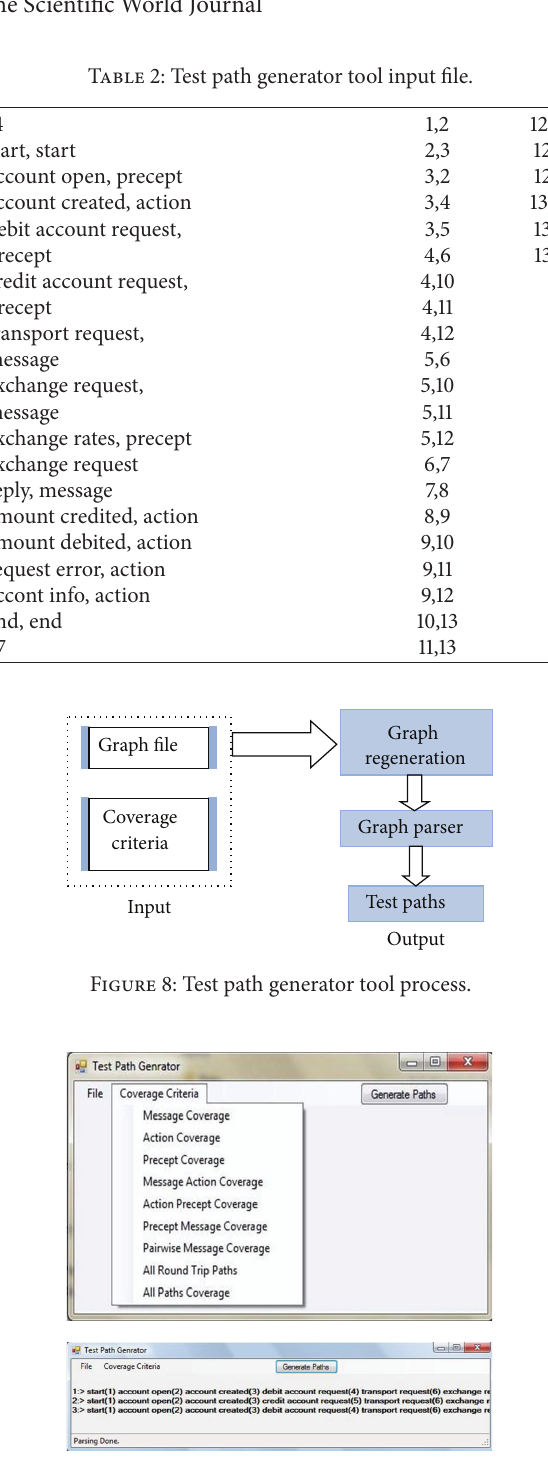
Figure 9: Test path generator